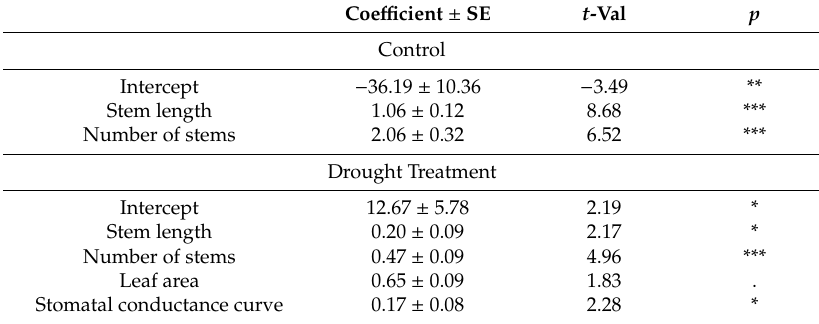
Table 3. The variables explaining the above-ground biomass accumulation under well-watered and drought conditions in the tested population; SE—measure of the uncertainty in the Coefficient; t value is derived from the t -statistic and p -value indicates the statistical significance for a given term within the model. Significance of differences are shown as p ≤ 0.1; * p ≤ 0.05; ** p ≤ 0.01; *** p ≤ 0.001.